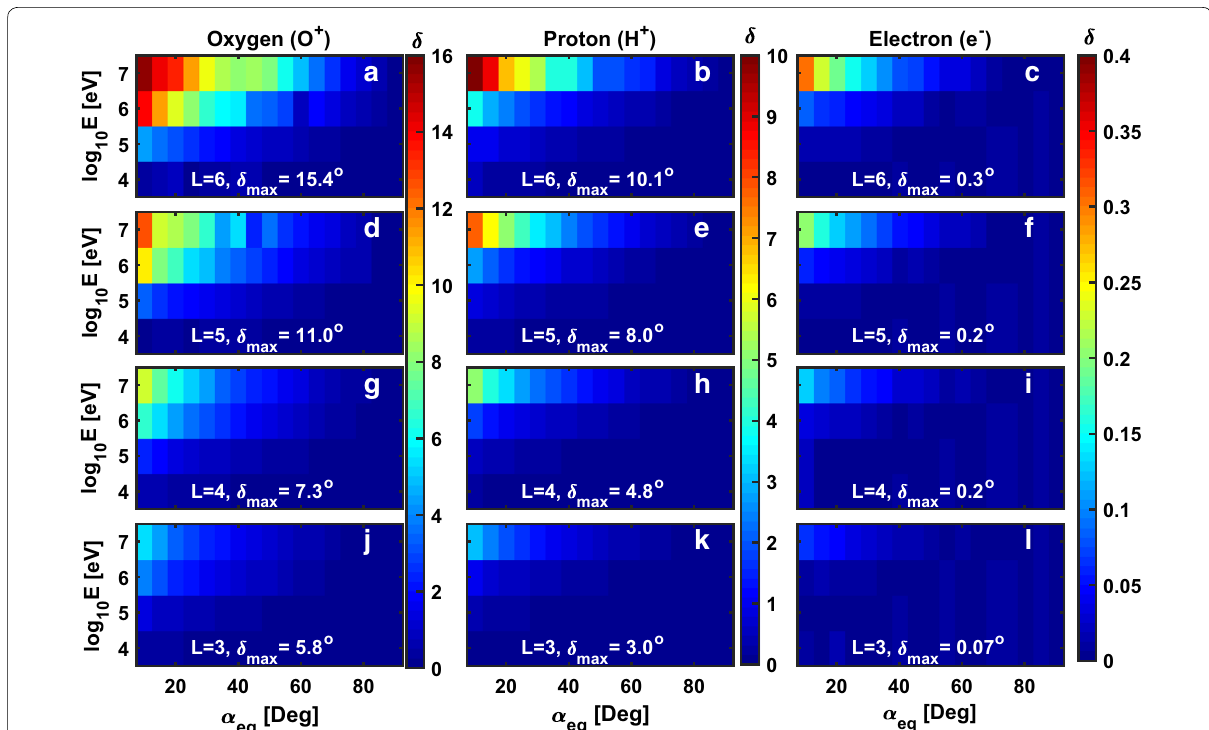
Fig. 7 The deviation of theoretical and simulation results of magnetic mirror points as a function of the equatorial pitch angle for different energies. a , d , g , j are for oxygen ions, b , e , h , k are for protons, and c , f , i , l are for electrons. The magnitude of the absolute deviation is shown by the colour